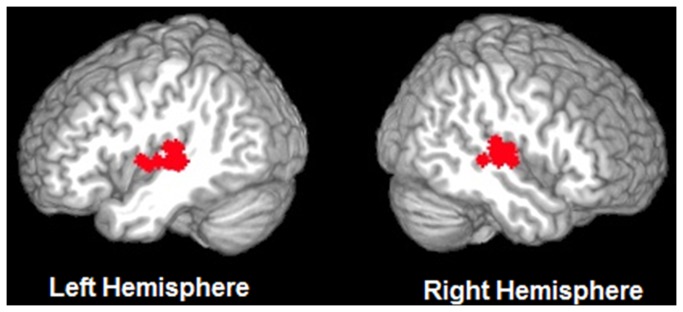
Displays the ROI selected in each subject (N=14) overlaid on a surface-rendered template brain. Voxels were selected using a functional localizer.